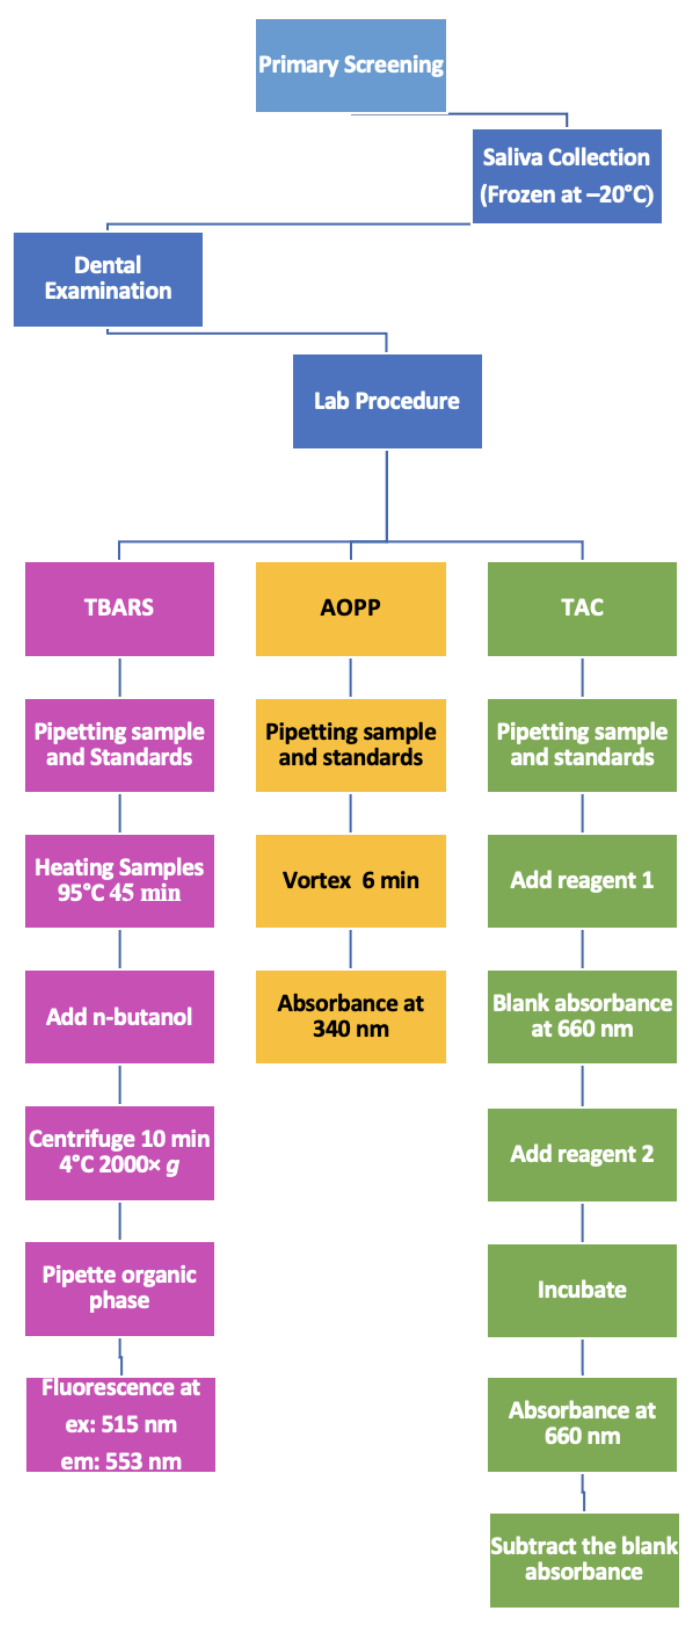
Figure 2. Brief chart for lab procedures measuring TBARS, AOPP, and TAC.